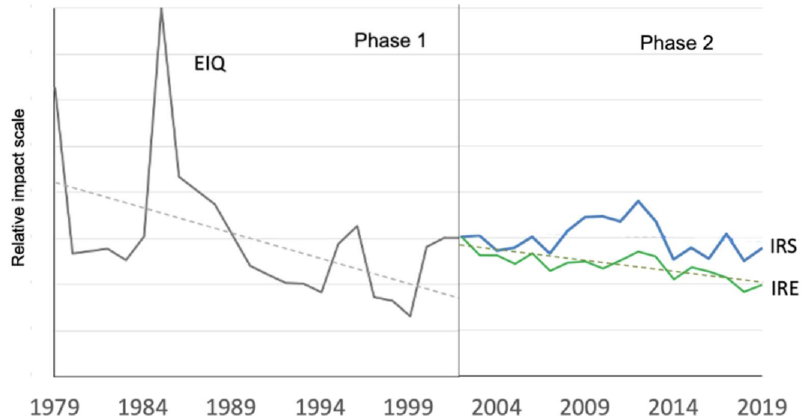
Figure 12. Summarized view of pesticide impacts based on annual treatments applied in commercial orchards from 1979 to 2019. Full lines: mean values; dotted lines: significant ( p < 0.05) linear trends. Orchards located at Franklin, Hemmingford and Oka (phase 1) and at Compton, Dunham, Franklin, Hemmingford, Oka, Sainte-Famille and Saint-Joseph (phase 2). Vertical bars represent standard error. The starting point of the IRS/IRE curves (2002) has been appended to the endpoint of the EIQ curve (2001). All lines and curves are